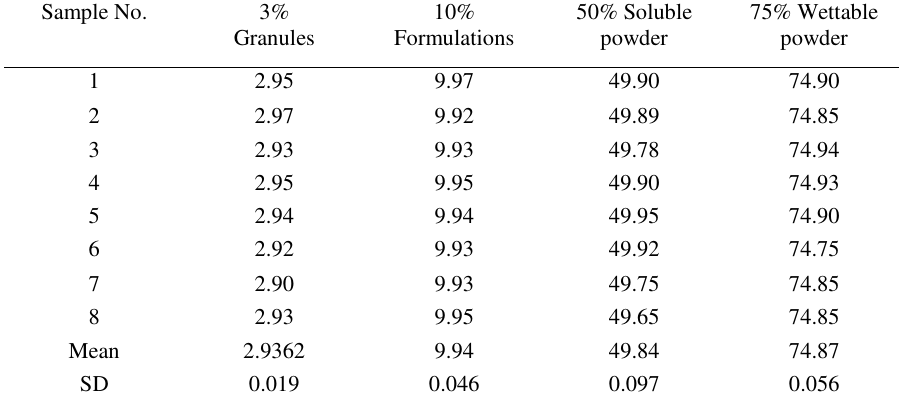
Table 4. Determination of carbofuran in insecticidal formulations using 4-aminobenzaldehyde. Sample